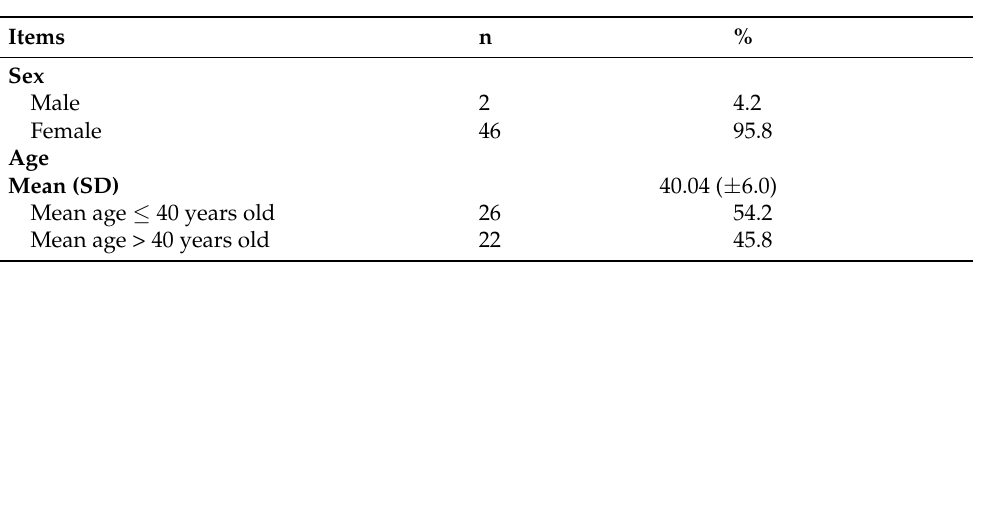
Table 1. Sociodemographic characteristics of the nutritionists (n =